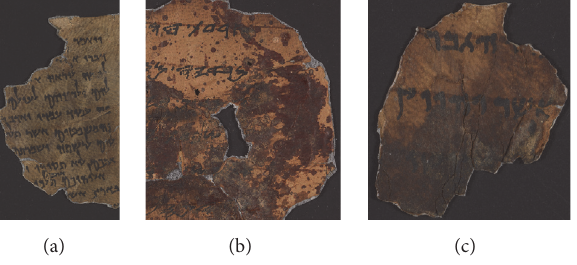
Figure1: Colorimages of someDead Sea Scrolls fragments: a well-preserved fragment of 4Q Deuteronomy (a), two fragmentswith darkening problems due to delamination—11Q Paleo Leviticus (b), and gelatinization-4Q Pesher Psalms B